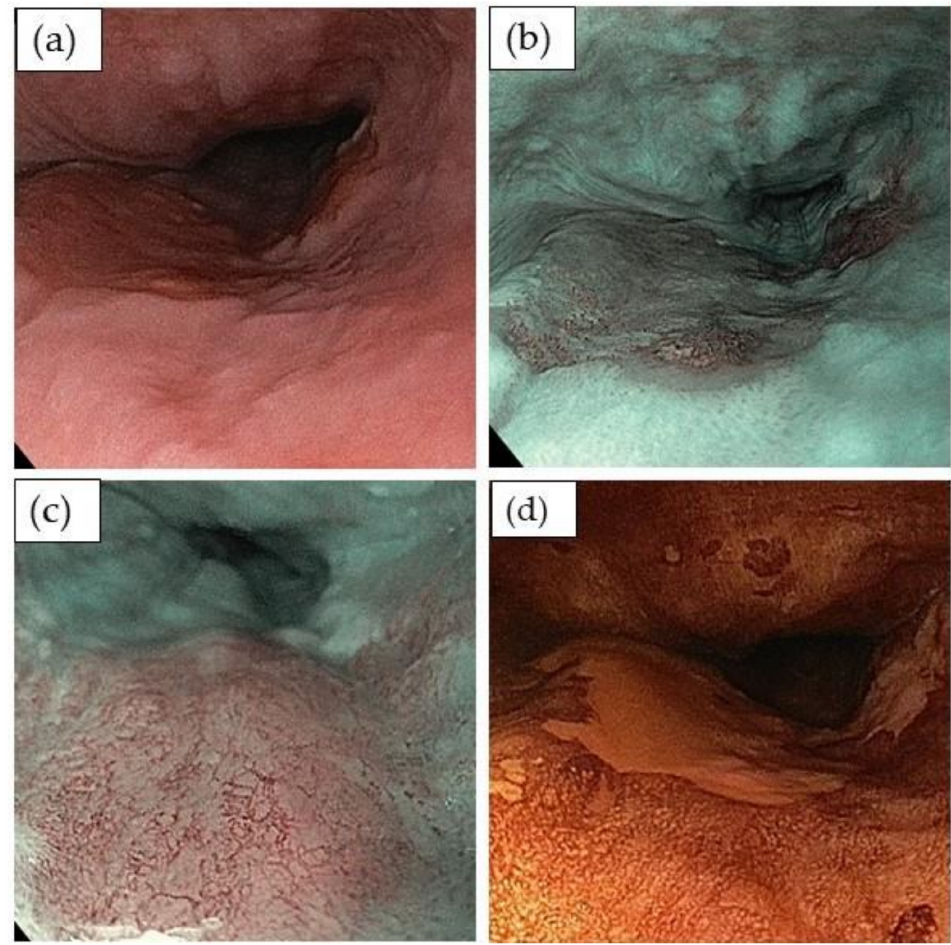
Figure 4. Endoscopic evaluation of early squamous cell cancer by endoscopic submucosal dissection: ( a ) irregular surface structure in the mid esophagus (white light imaging); ( b ) virtual chromoen- doscopy of this area shows a brownish are with better definition of the borders (narrow band imaging); ( c ) close view of the lesion showing vessel irregularities (type B2 vessels); ( d ) chromoendoscopy with 0.5% Lugol’s solution nicely delineates the borders of the lesions and is ideally used immediately before starting an endoscopic